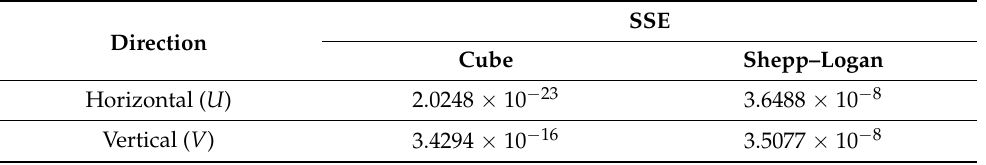
Figure 3. The level of consistency between the TPC and the PTOC. Here, U and V represent the horizontal and vertical directions in the projections, respectively. In the U direction, TPC and PTOC are H-TPC and H-PTOC, respectively. In the V direction, TPC and PTOC are V-TPC and V-PTOC, respectively. ( a , b ) Validation of trajectory consistency in Cube. ( c , d ) Validation of trajectory consistency in Shepp–Logan. Table 3. The similarity measures between TPC and PTOC. In the horizontal direction ( U ), the SSE between H-TPC and H-PTOC is calculated. In the vertical direction ( V ), the SSE between V-TPC and V-PTOC is calculated.